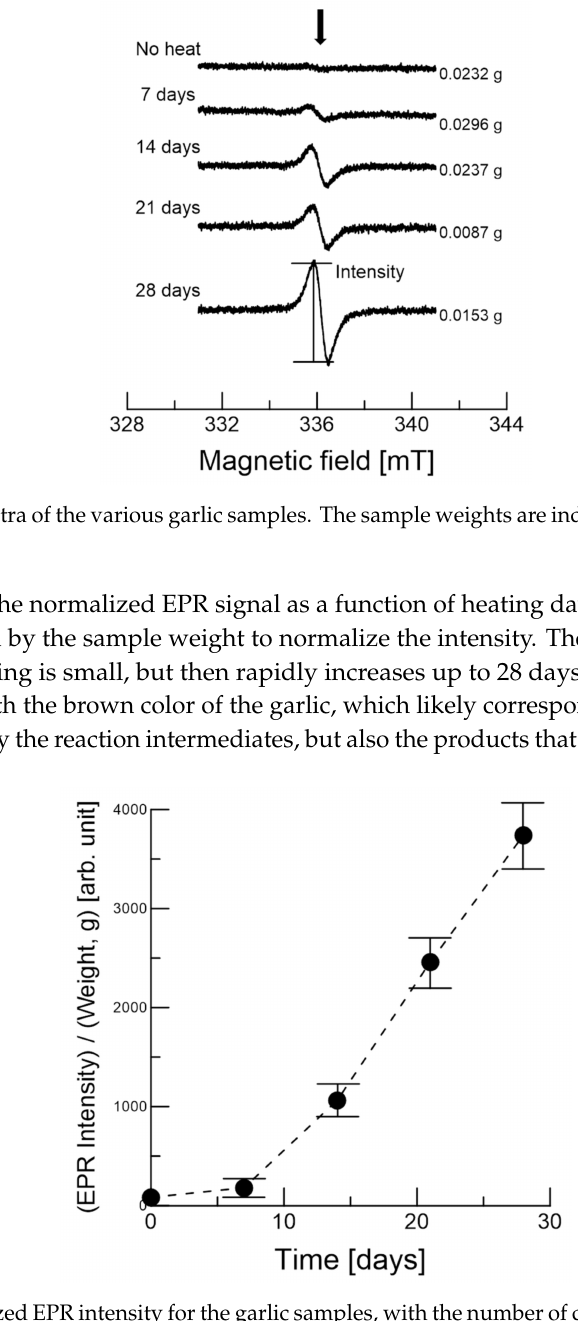
Figure 4. Normalized EPR intensity for the garlic samples, with the number of days of heating indicated. The error bars are mean ± SE. Data corresponds to the average of four di ff erent sample